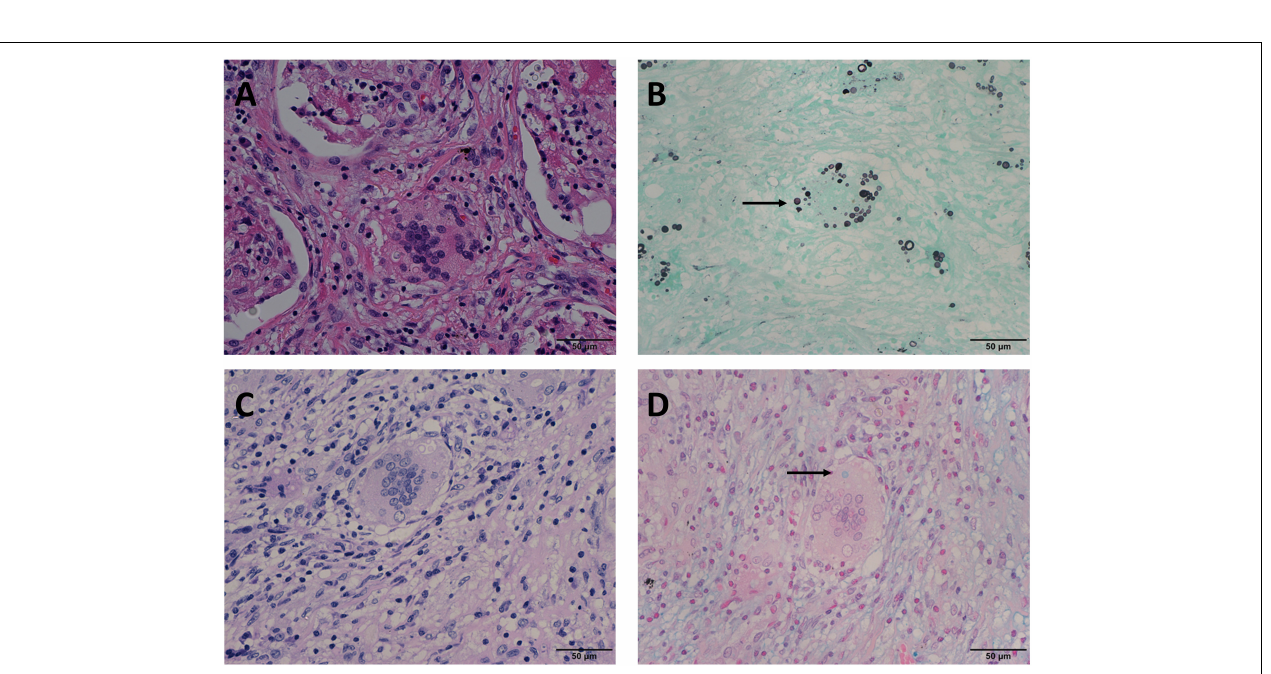
FIGURE 3 | Mode C: GMS(+), PAS(–), AB(+) in the same view of lung tissues with pulmonary cryptococcosis (female, aged 56 years, multiple nodules, maximum diameter of 1.4 cm). (A) H&E staining reveals circular structures resembling Cryptococcus spores. (B) GMS(+) highlights brown-black Cryptococcus spores (arrow). (C) PAS(–) shows no obvious magenta Cryptococcus but reveals colorless or reddish round-like structures. (D) AB(+) reveals Cryptococcus blue (arrow) within the multinucleated giant cells, with interfering blue acid mucosubstances. GMS, Grocott methenamine silver; PAS, periodic acid-Schiff; AB, Alcian blue; H&E, hematoxylin and eosin. (Original magnifications: A–D , × 400).